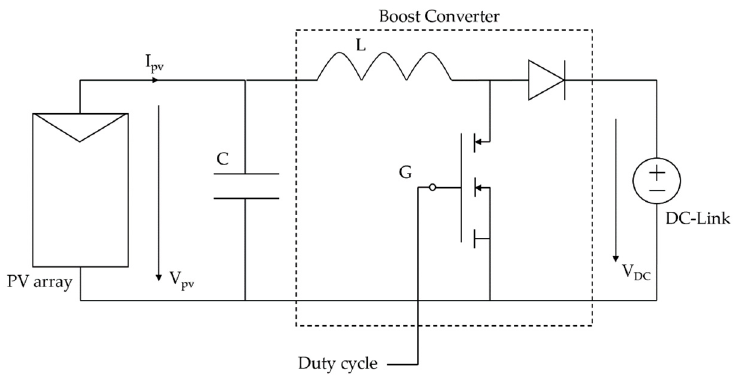
Figure 2. Single-stage grid-connected PV system.